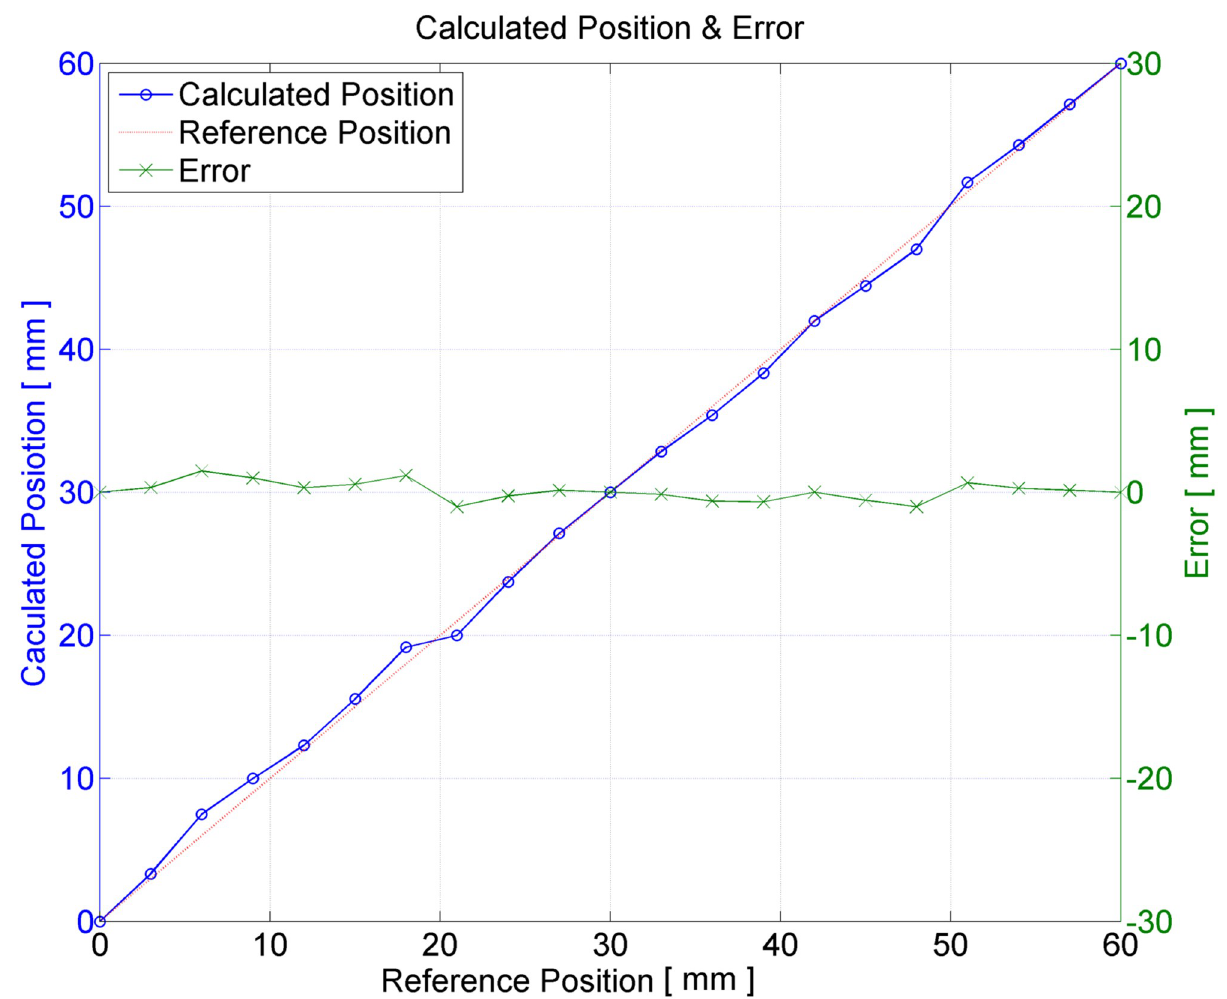
Fig 10. Result graph of calculated position and error. Red dotted line is ideal line and blue solid line (marked with circle) is reference versus calculated position result. And green solid line (marked with x) is position error compared with ideal position.